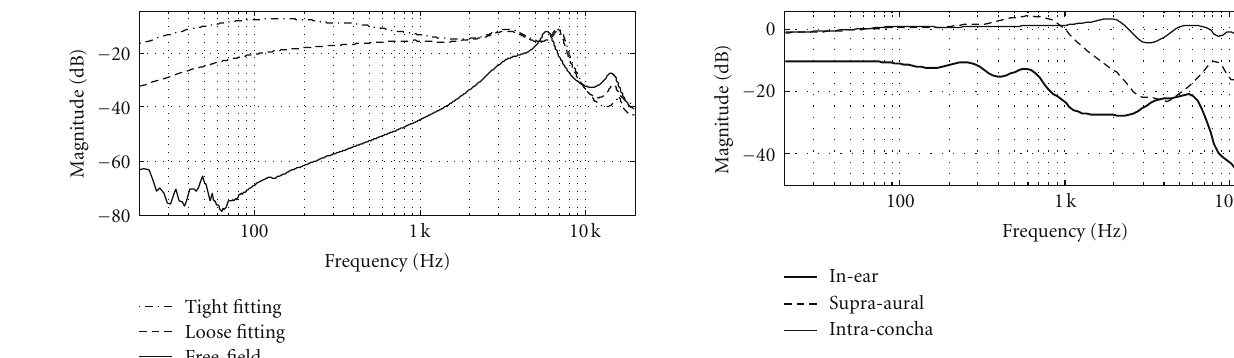
Figure 3: Isolation curves of di ff erent headphones (with 1/3 octave smoothing)